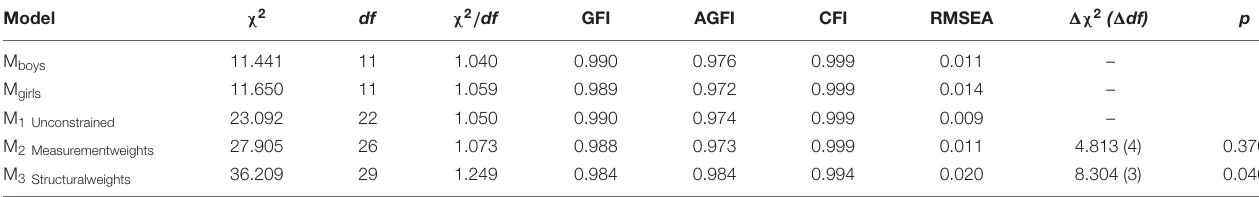
TABLE 3 | Comparison of indirect effects models.